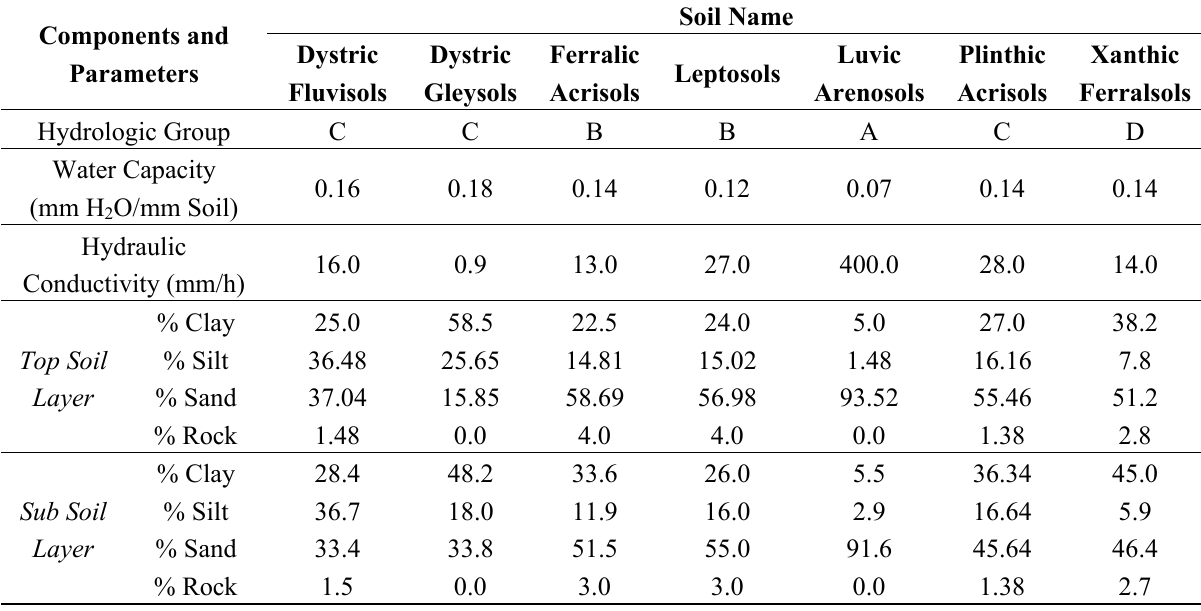
Table 1. Soil components and parameters in Huong River